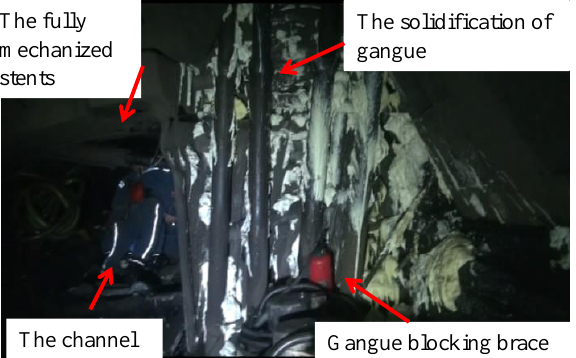
Figure 19. Gangue consolidation.